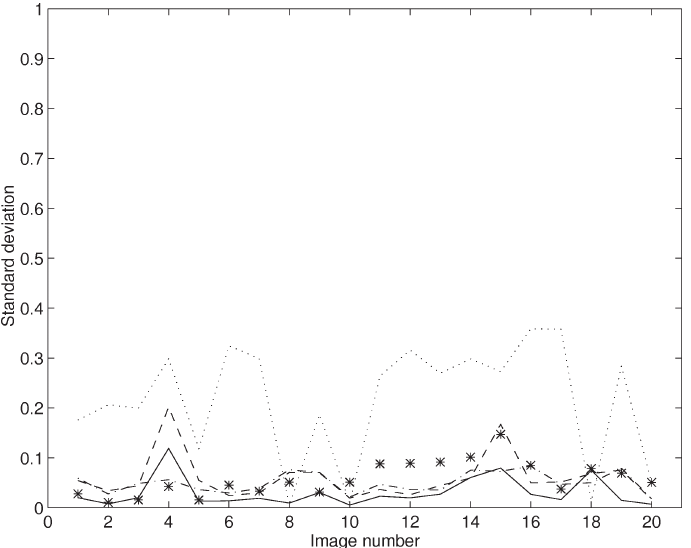
Fig. 7. Standard deviations for the four different ML methods and the proposed method on 20 tested fields of view, where 1–10 are stained using DAB and 11–20 are stained using Ni-DAB. Line: training image variation; dashed line: intraoperator variation; dash–dot line: intraoperator and training image variation; dotted line: classification image variation; asterisks: proposed